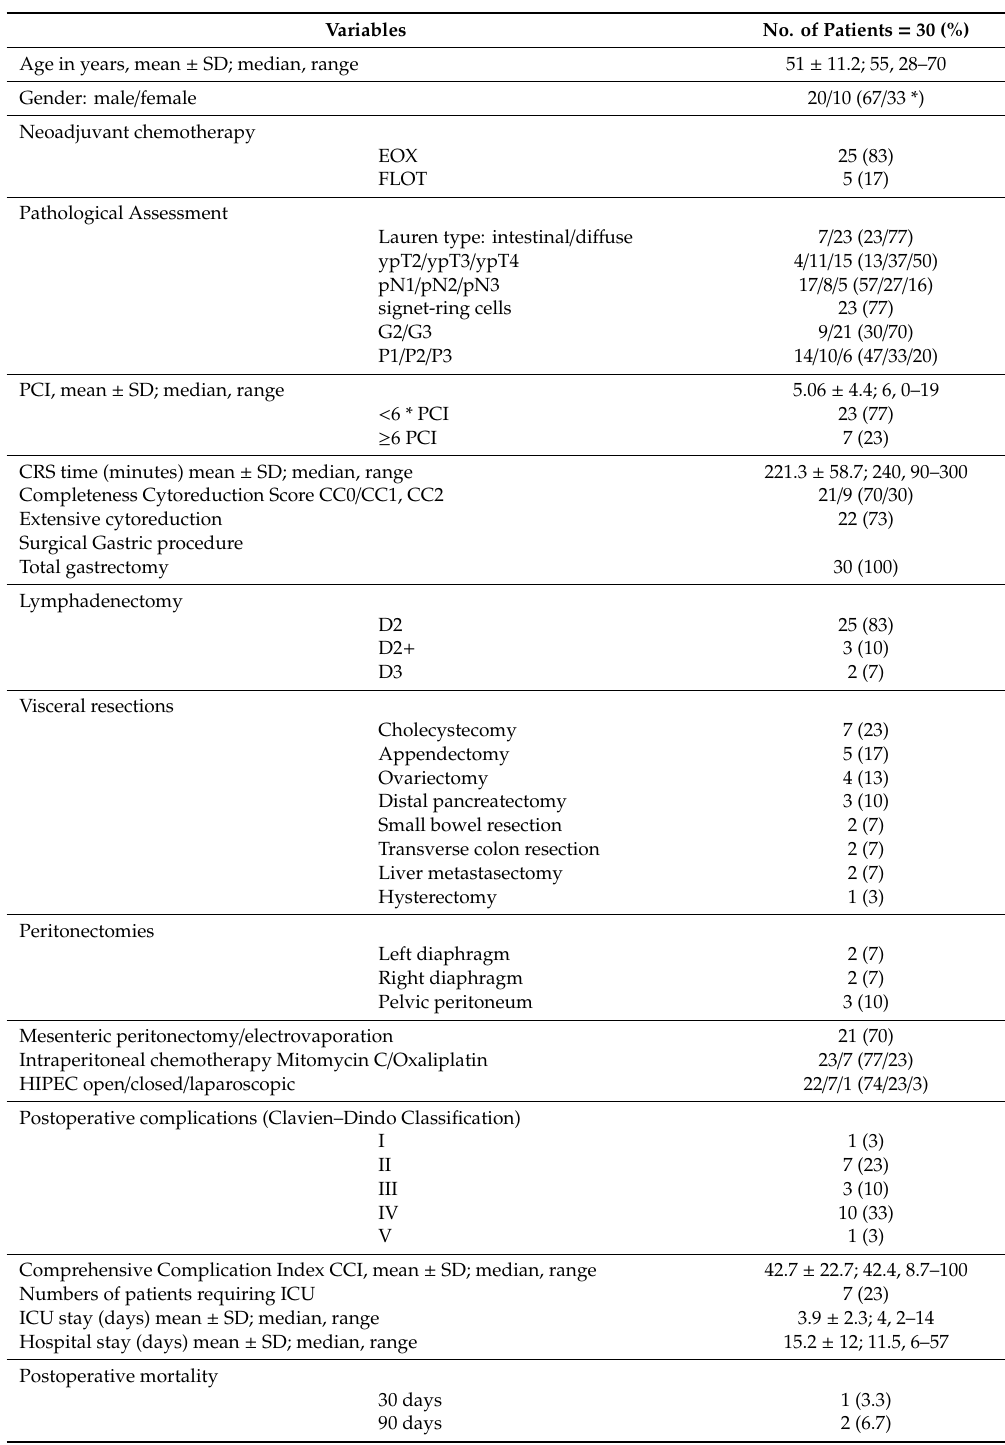
Table 3. Patient demographic and treatment related